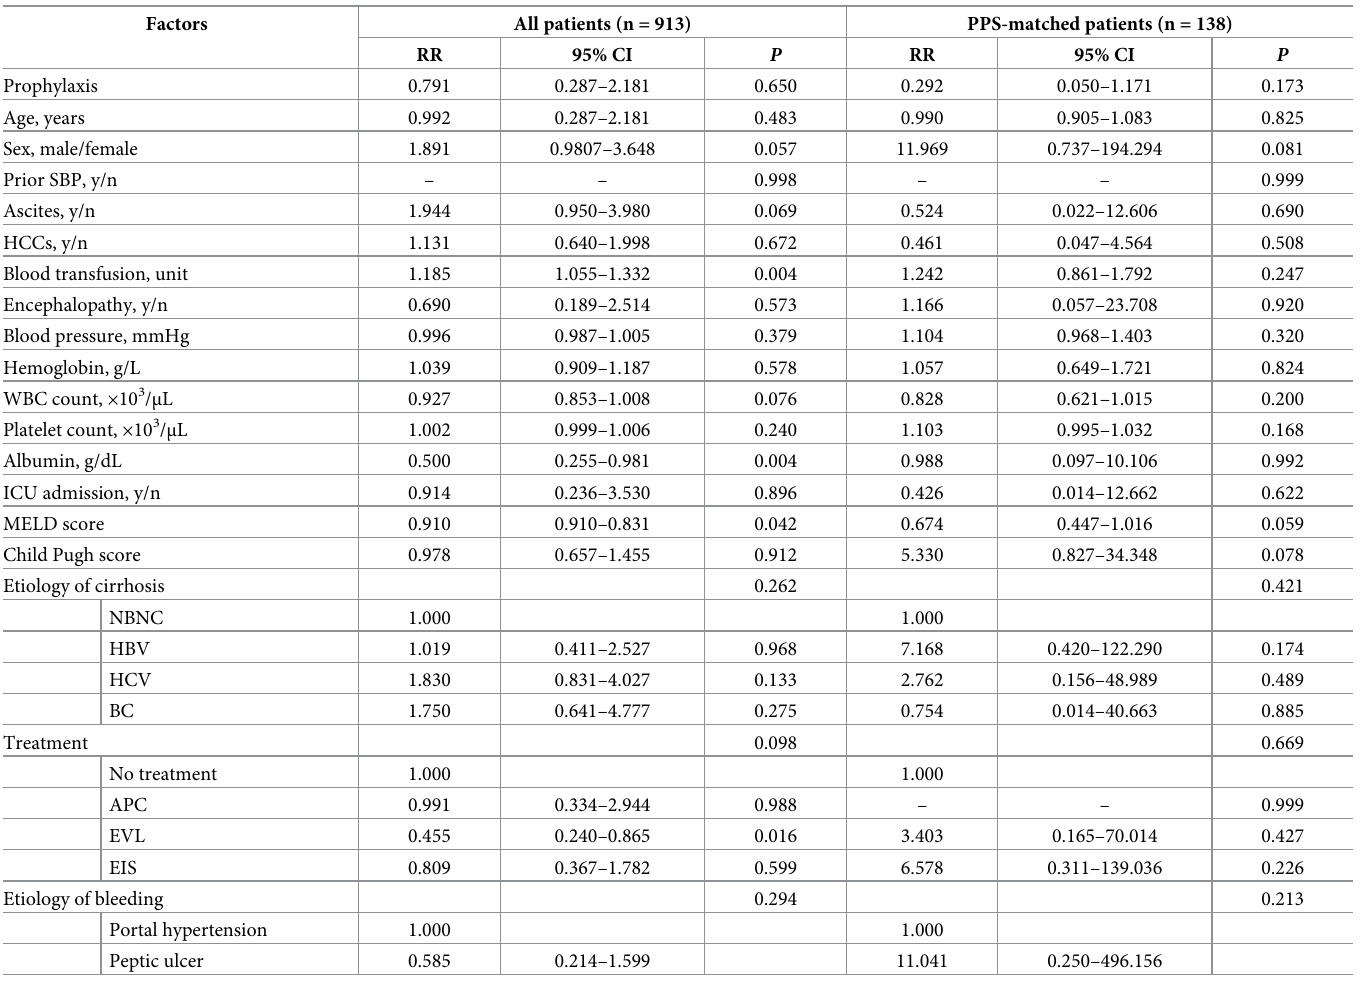
Table 5. Factors associated with risk of rebleeding within 14 days †